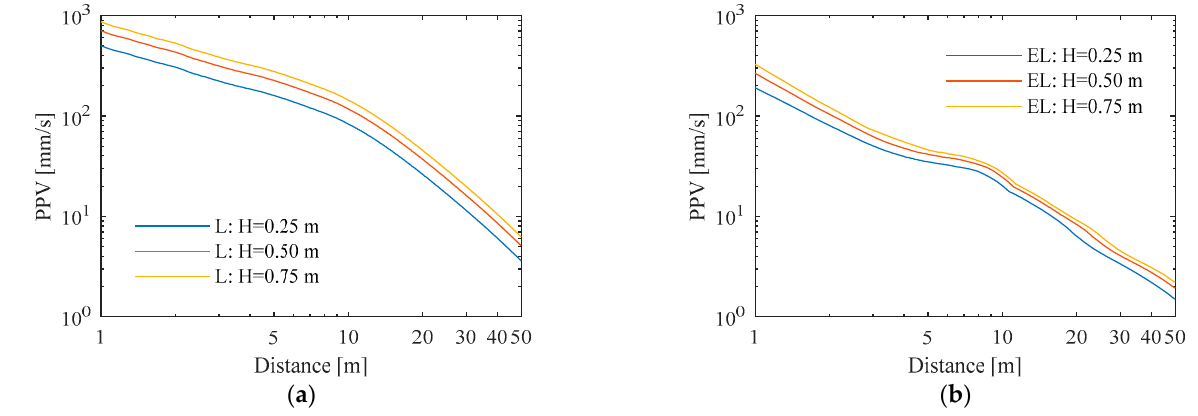
Figure 13. PPV versus distance from the pile due to impact pile driving for different heights of fall of the hammer: ( a ) linear analysis; ( b ) equivalent linear analysis.